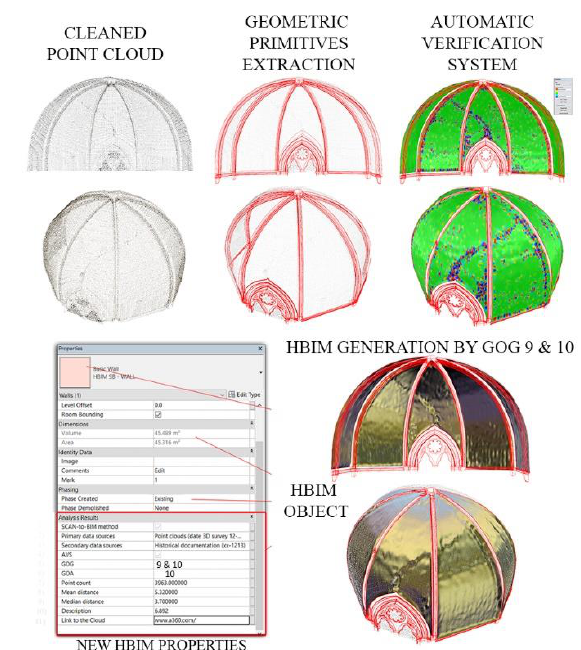
Figure 3. The generation of new HBIM object based on a scan- to-BIM process needs new parameters to communicate to different users the GOA20 achieved during the